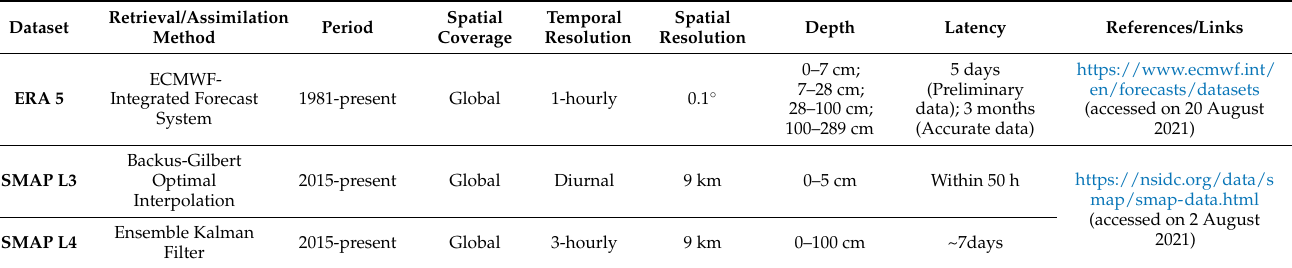
Table 2. Summary of ERA5 and SMAP soil moisture